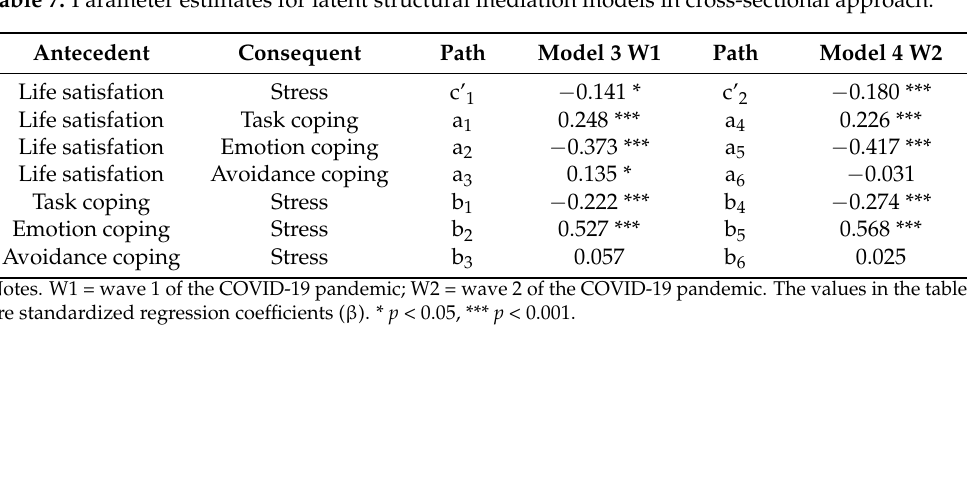
Table 7. Parameter estimates for latent structural mediation models in cross-sectional